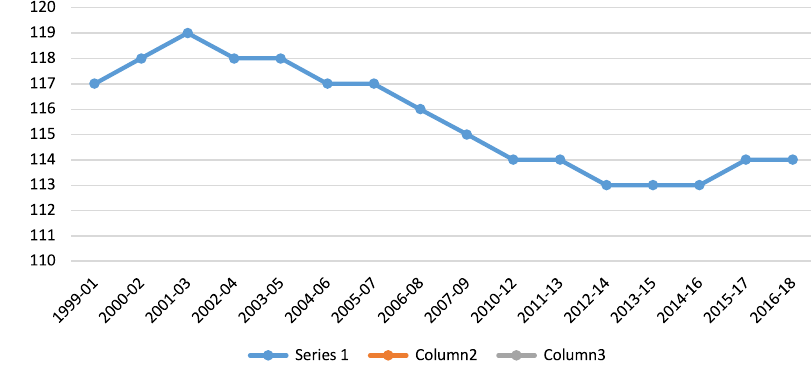
Fig. 3 Average dietary energy supply adequacy (%), 3-year average, 1999 – 2018. Expresses the dietary energy supply (DES) as a percentage of the average dietary energy requirement (ADER). Jamaica ’ s average supply of calories for food consumption has been normalised by the average dietary energy requirement estimated for its population to provide an index of adequacy of the food supply in terms of calories. Note : Data sourced from